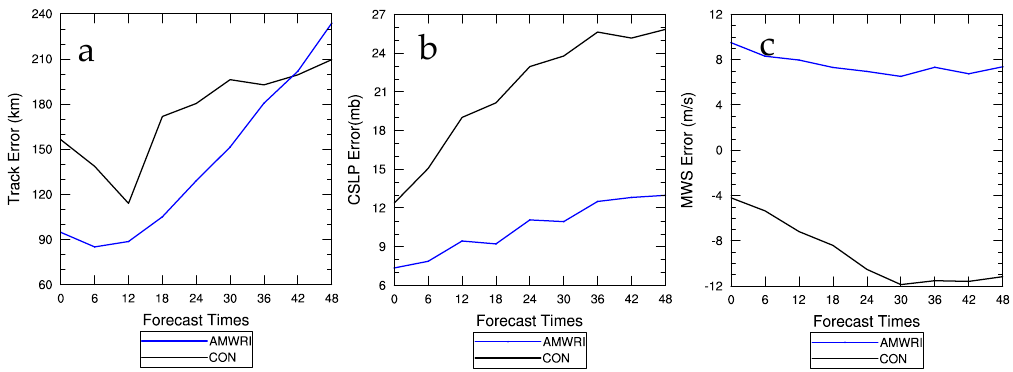
Figure 9. ( a ) Aggregated absolute track errors, ( b ) mean central sea level pressure errors, and ( c ) maximum wind speed as a function of forecast range from two experiments. The error statistics were obtained from 12 48 h forecasts.